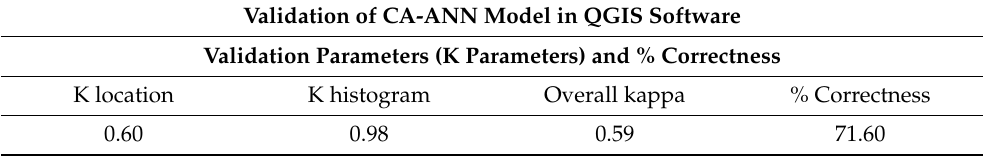
Figure 7. LULC simulation map for the year 2047. Table 5. Validation of CA-ANN model for LULC changes for the year Table 5. Validation of CA-ANN model for LULC changes for the year 2047.